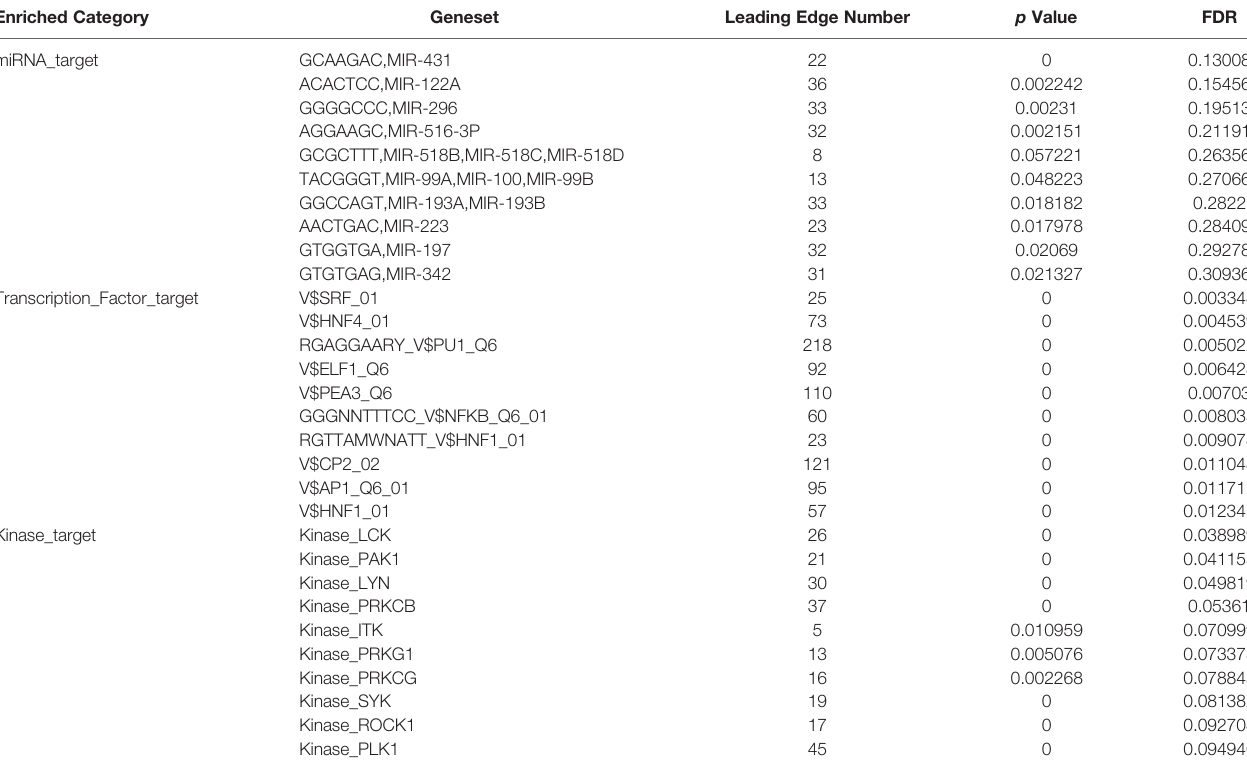
TABLE 2 | The Kinases, miRNAs and transcription factors-target networks of ATP1B3 in HCC. Enriched Category